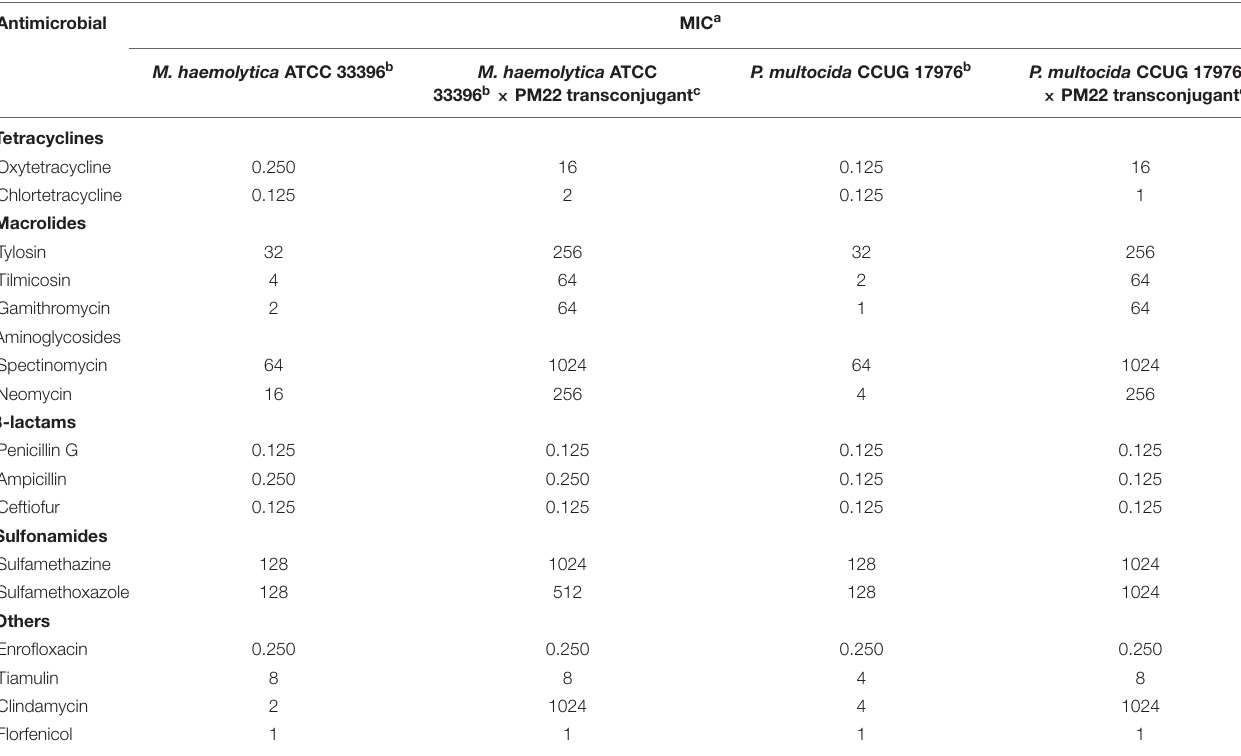
TABLE 1 | MIC changes in